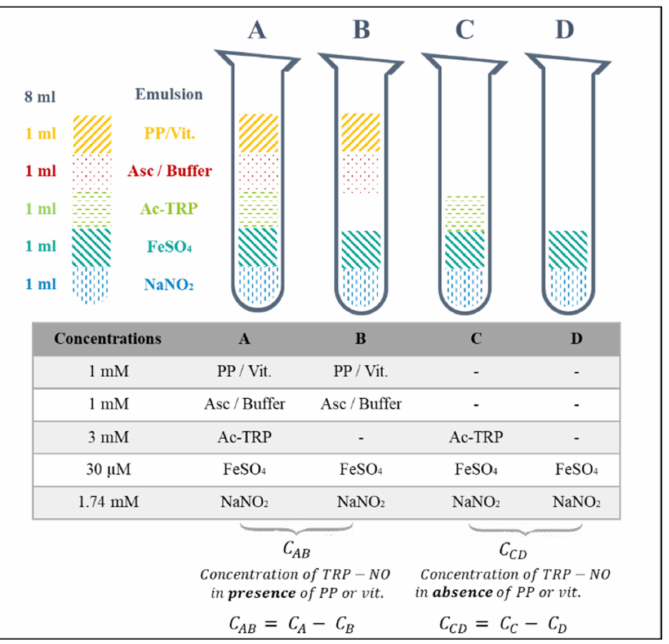
Figure 2. Experimental design to screen the modulation of the chemical reactivity induced by vegetable molecules. Asc: ascorbate; PP: polyphenol; Vit.: vitamin; FeSO 4 : iron (II) sulfate heptahy- drate; NaNO 2 : sodium nitrite; Ac-TRP: acetyl-tryptophan; TRP-NO: N-acetyl-DL-nitroso-tryptophan, C: